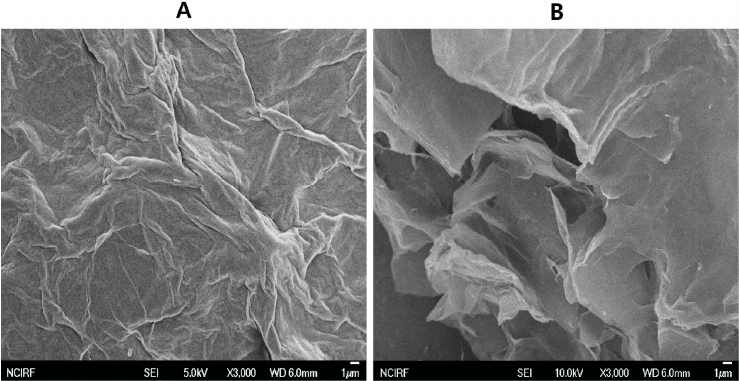
Figure 5 . SEM images of GO and UA-rGO. Representative SEM images of GO ( A ) and UA-rGO ( B ) dispersions at 500 μ g/mL.